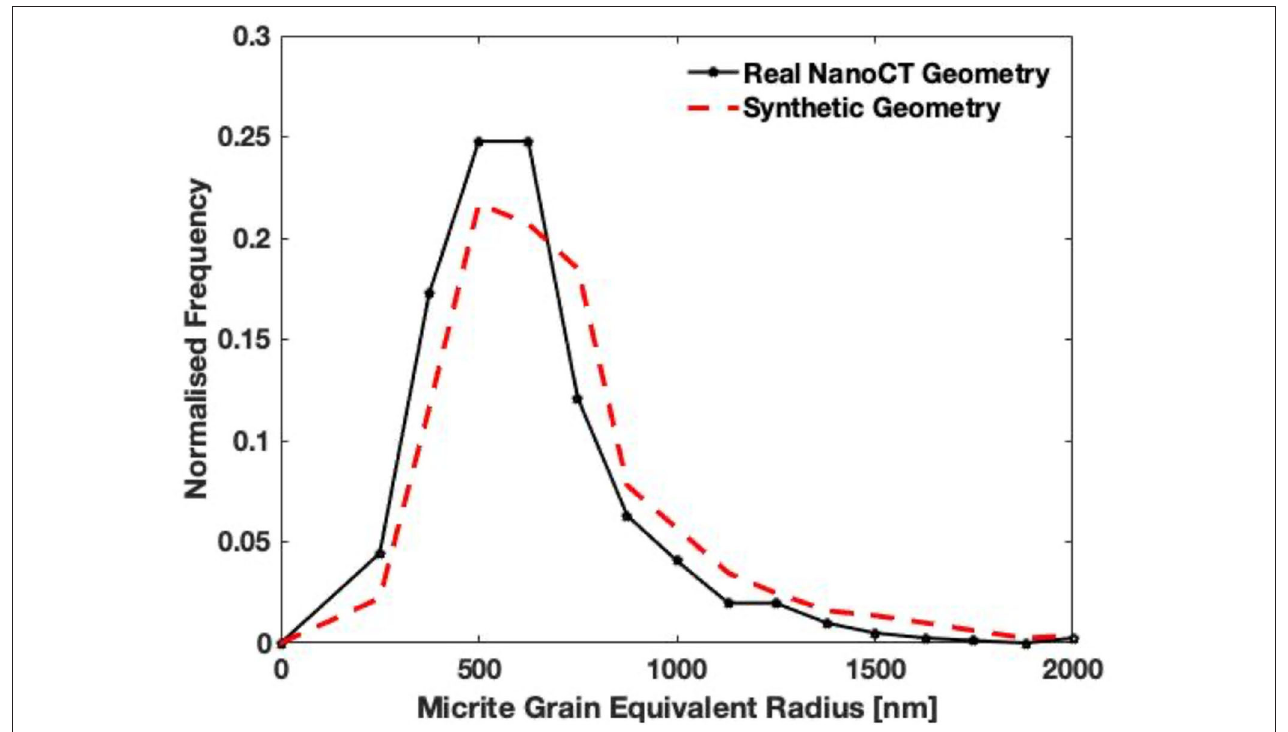
FIGURE 5 | Micrite grain equivalent radii frequency histograms for the real geometry imaged by nano-XRM (black) and the 41% porosity synthetic image